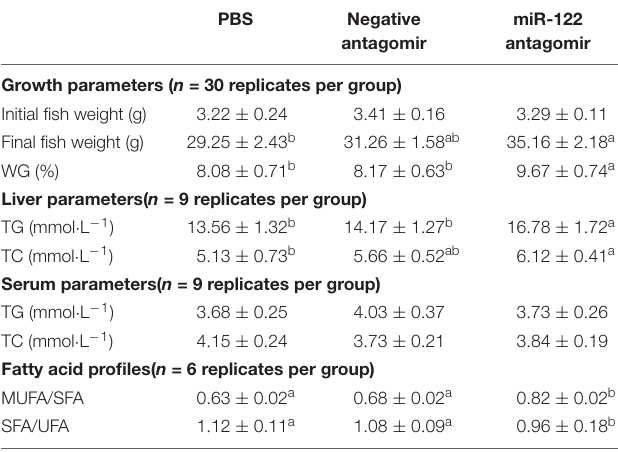
TABLE 2 | Growth, biochemical parameters, and fatty acid profiles of juvenile GIFT injected with PBS, negative antagomir, or miR-122 antagomir every 6 days for 40 days.